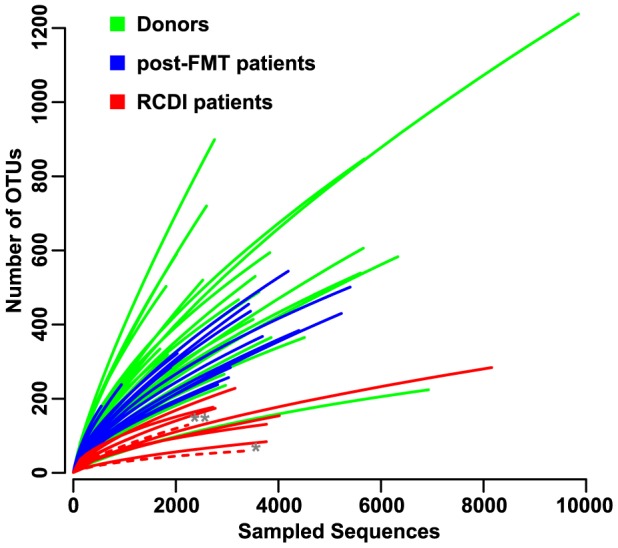
Microbiota rarefaction curves showing fecal microbiota diversity in RCDI (red) and post-FMT (blue) patient and donor (green) samples.Each curve shows the average number of OTUs found in a given number of sampled sequences. OTUs can be treated as equivalent to taxonomic species in the sequence space. RCDI samples are marked from patient #6a (*), who experienced antibiotic-induced relapse and was treated by FMT again as patient #6b (**).